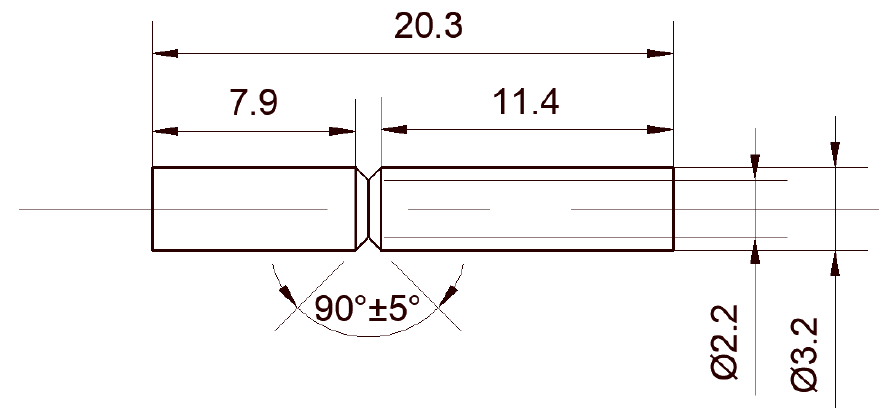
Figure 1. The shape of standard auger sample (mm).